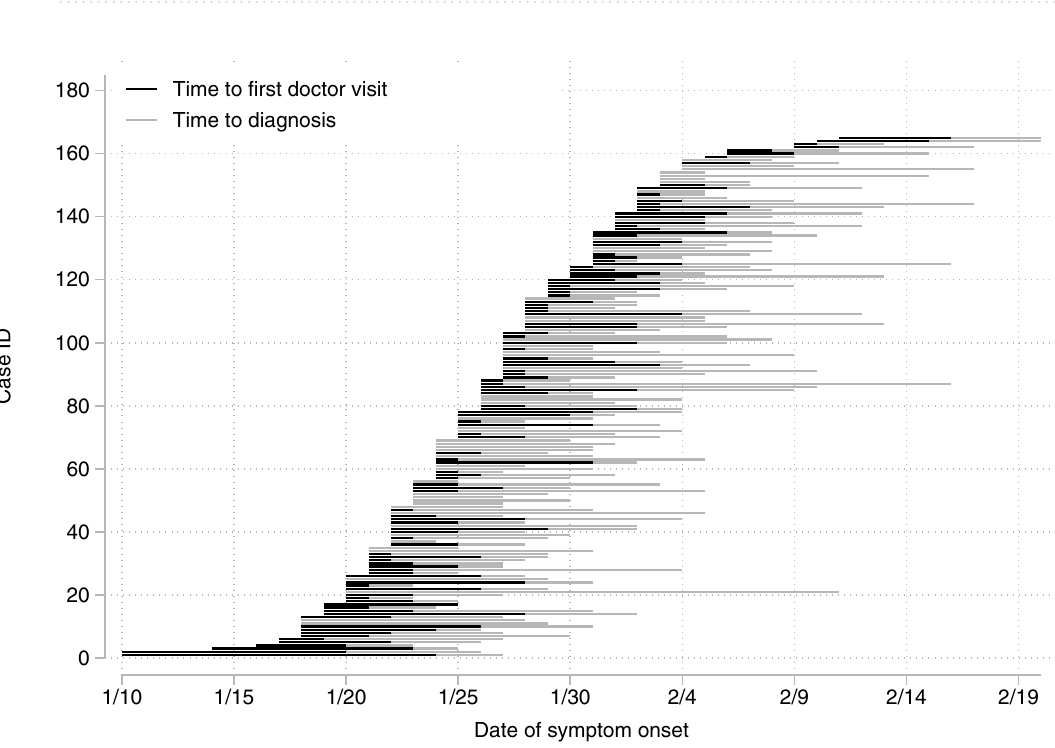
Figure 2. Time from COVID-19 symptom onset to first doctor visit and confirmation of COVID-19